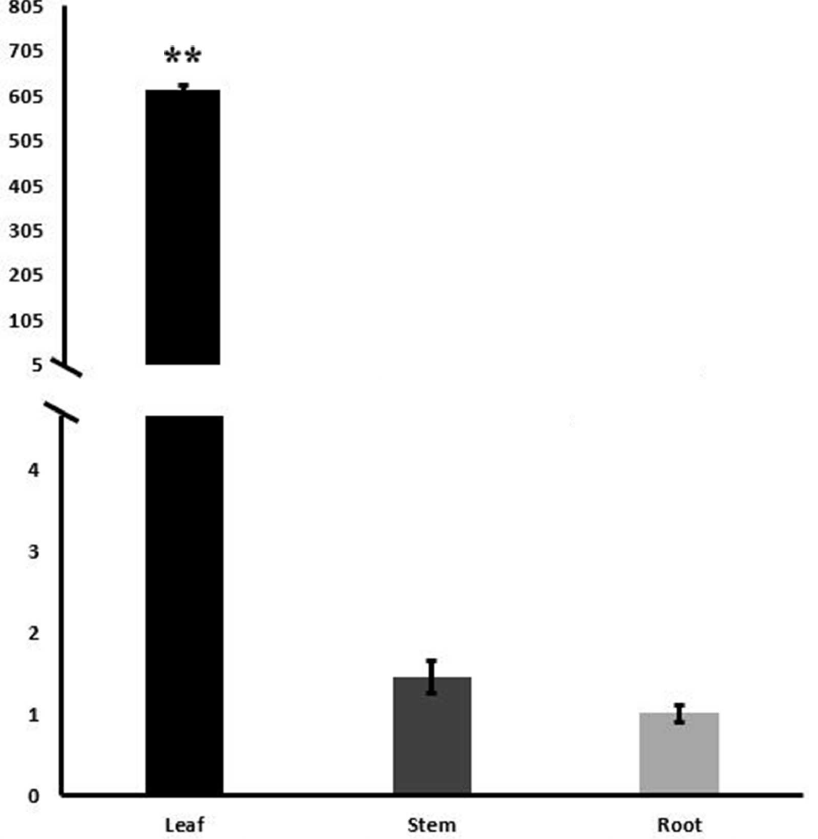
Fig 5. Tissue-specific transcript profiling of WRAB18 in root, stem and leave. The root, stem and leave samples were collectedfrom two-leaf-period wheat seedlingsand qRT-PCR was performed. Data plotted are the mean values ± SD from three independent experiments (n = 3; biologicalreplicates). Statistically significantdifferences were analyzedusing the Student’s t-test ( * p < 0.05or ** p <